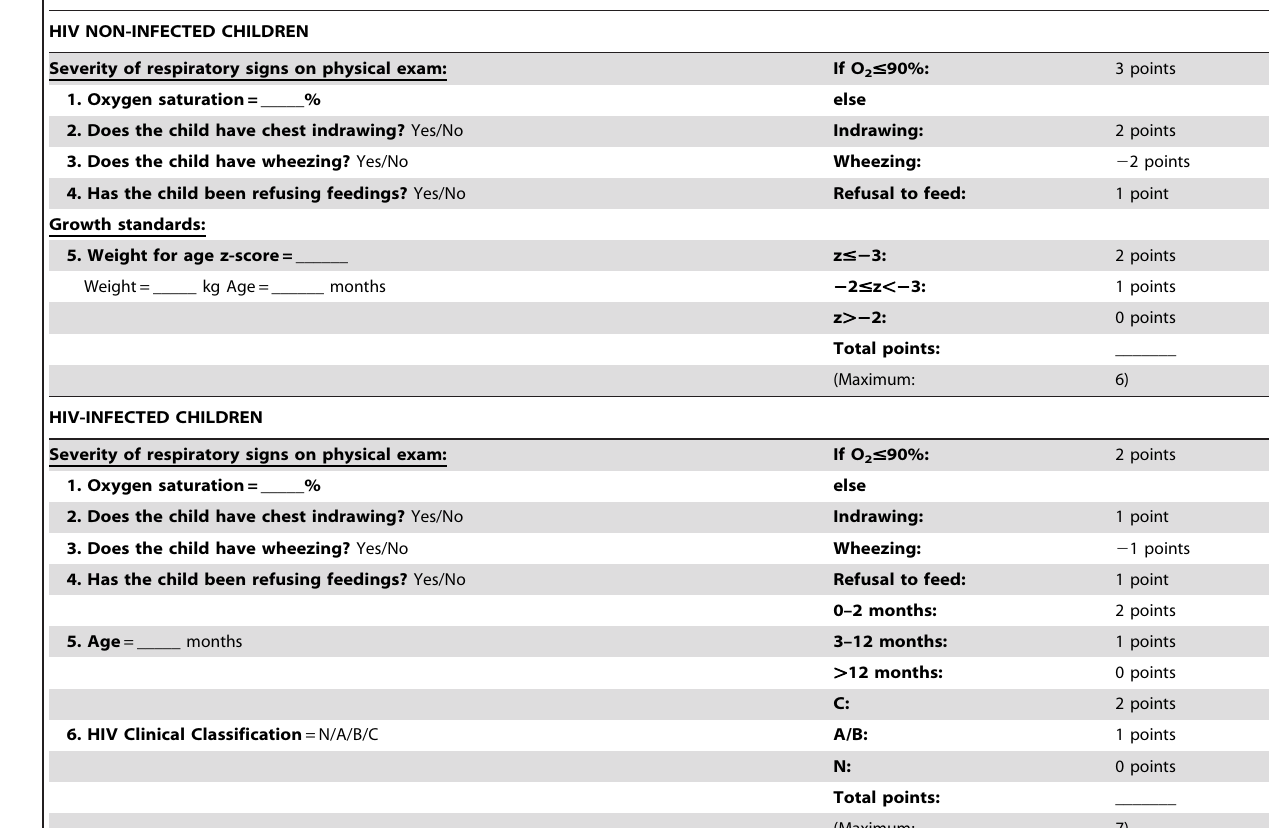
Table 3. RISC scoring system.